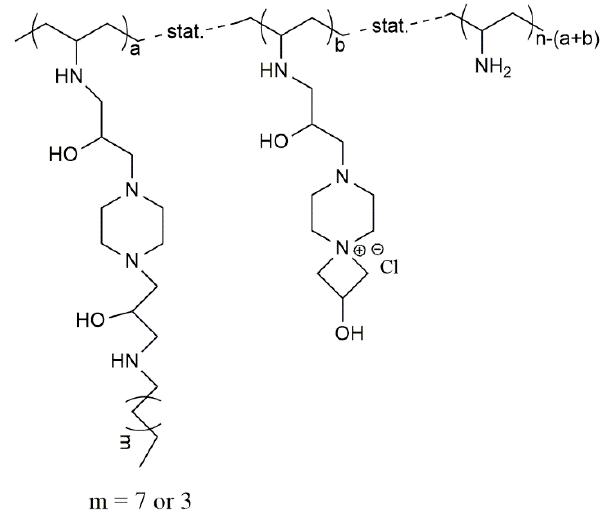
Figure 8. Chemical structure of poly(vinyl amine) with cationic, azetidinium and alkyl groups on the side chain [151].